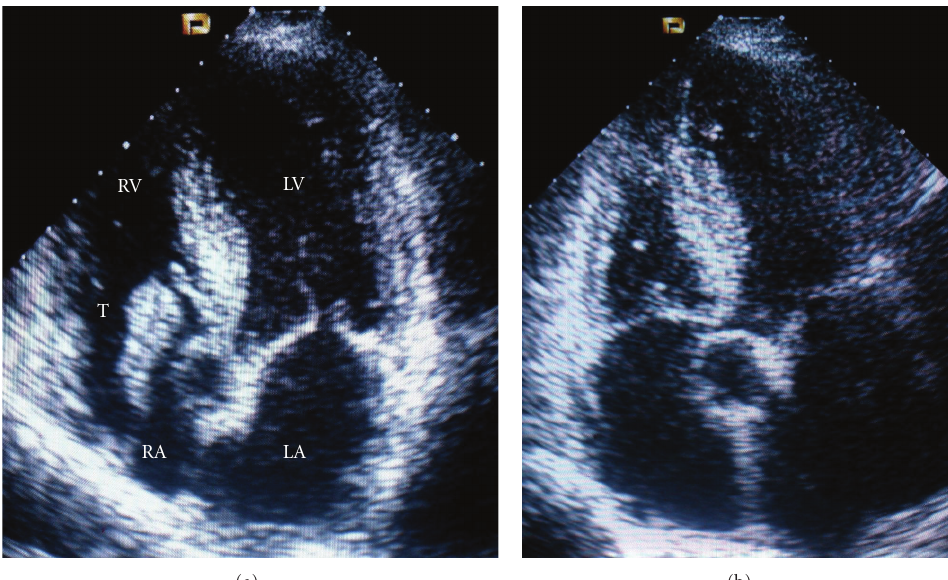
Figure 1: (a) Transthoracic apical five-chamber view showing the thrombus with thin stalk prolapsing through the tricuspid valve. (b) Same view after oral anticoagulation therapy. Complete dissolution of the thrombus. LA, left atrium; LV, left ventricle; RA, right atrium; RV, right ventricle; T, thrombus.